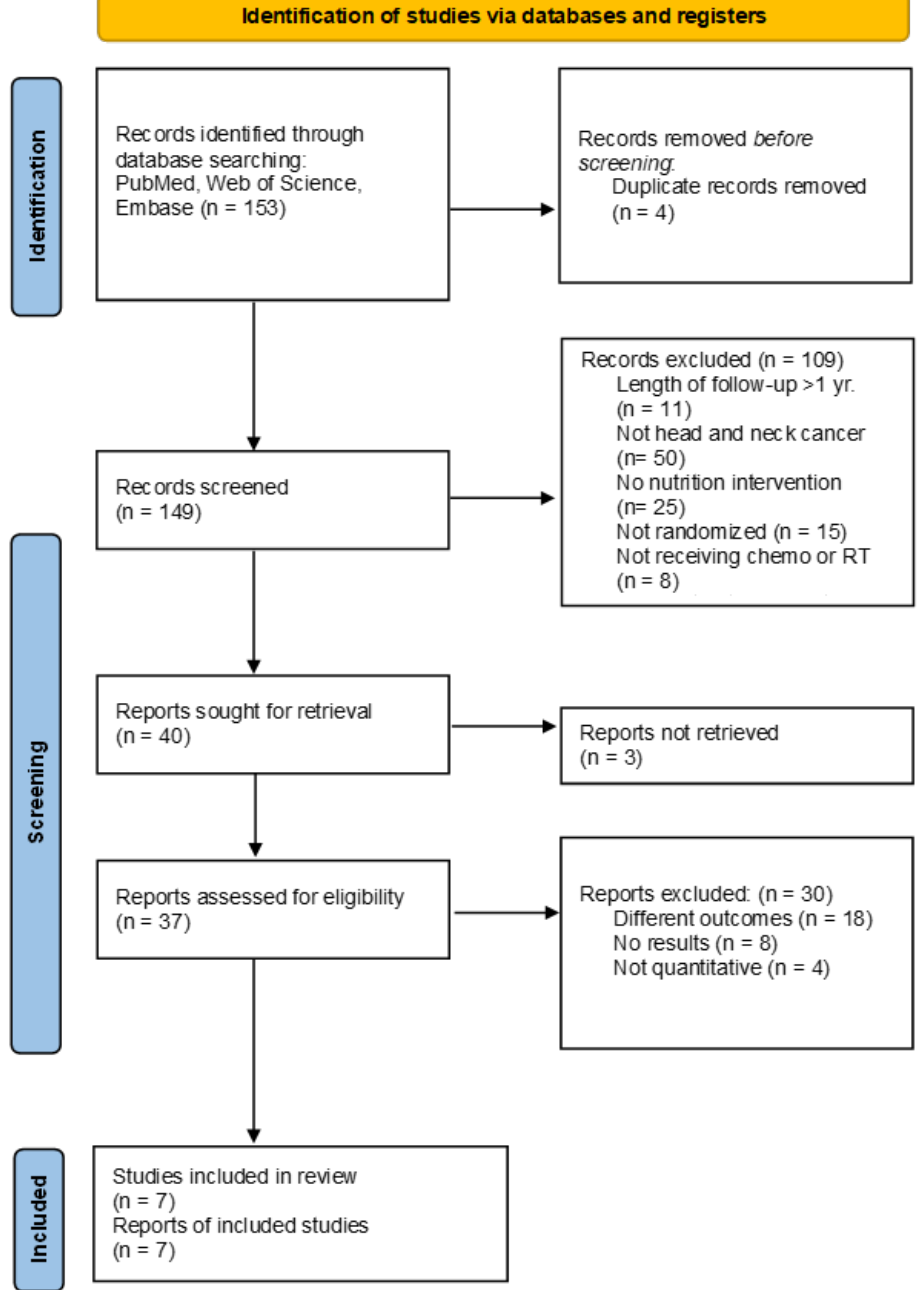
Figure 1. PRISMA flow diagram of studies reporting nutrition interventions in head and neck cancer patients.